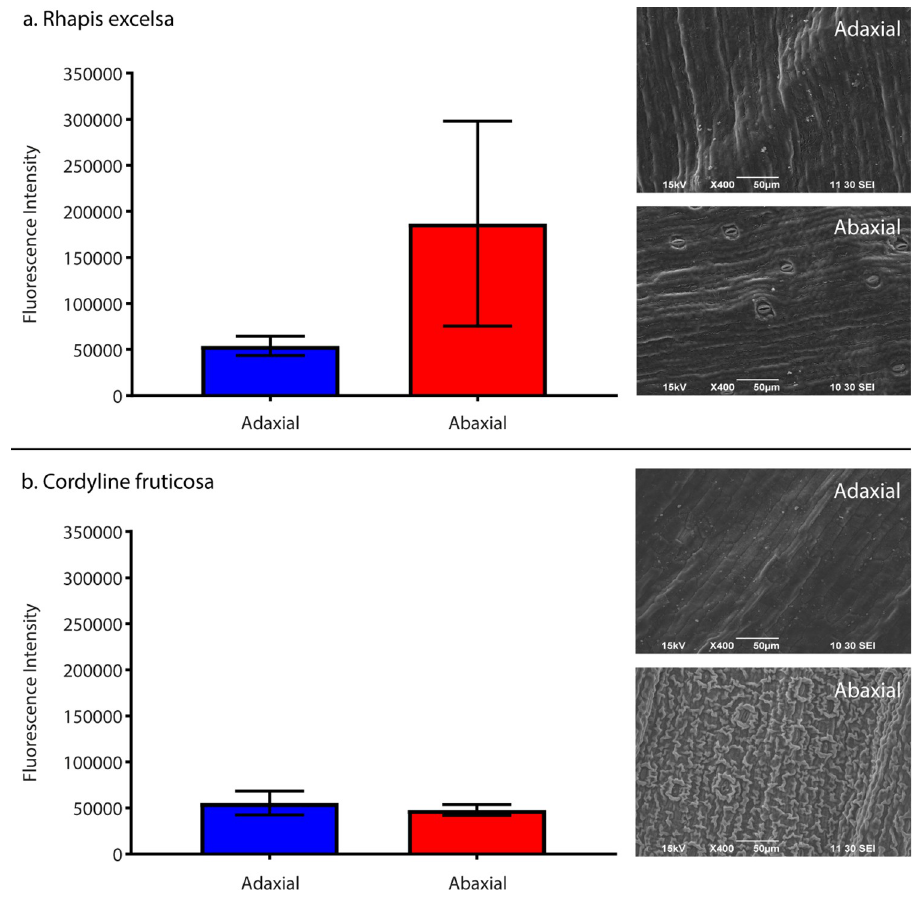
Fig 5. Reactive oxygen species assay of adaxial and abaxial leaf surfaces. A more than 2-fold increase of ROS production was observed on the abaxial surface of (a) R . excelsa . However, this phenomenon was absent in (b) C . fruticosa . The fluorescence intensity readings of the ROS assay are listed in S3 Table. The difference in concentration of ROS between adaxial and abaxial surface of R . excelsa was statistically significant using Welch’s t-test (S5 Table). The photographs were taken by Kenny J.X.